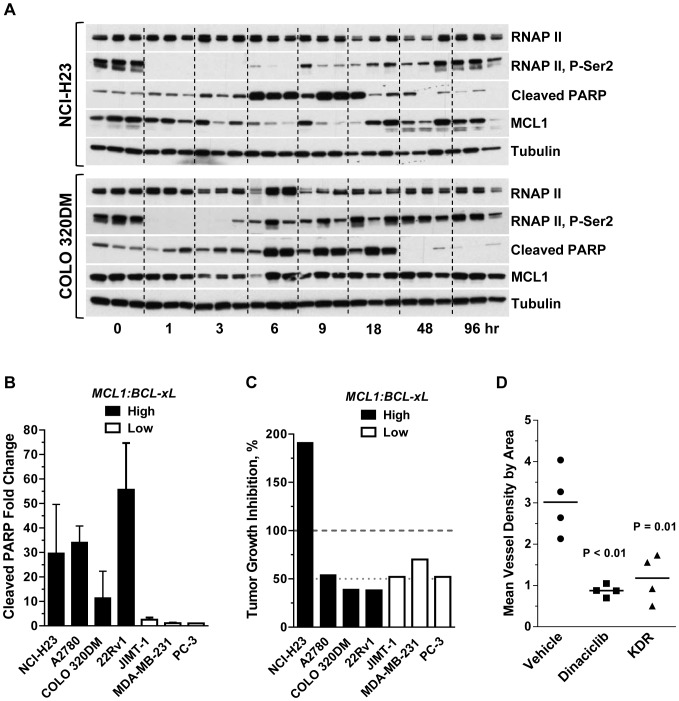
Dinaciclib exhibits apoptotic-induction, tumor efficacy and antiangiogenic activity in human tumor xenograft models.(A) Immunoblot analysis of lysates prepared from NCI-H23 and COLO 320DM xenograft tumors resected at 1, 3, 6, 9, 18, 48 and 96 hr after a single 40 mg/kg, i.p. dinaciclib injection. Time 0 is a 1 hr vehicle treatment. Represented are three tumors from three animals per time-point. α-tubulin is included as a loading control. Quantification of the cleaved-PARP fragment in these lysates is shown in supplemental Figure S4. (B) Quantification of cleaved-PARP fragment in lysates prepared from tumors resected 6 hr post-administration of vehicle or a single dose of dinaciclib at 40 mg/kg, i.p. Xenograft models designated as MCL11:BCL-xL high (filled bars) or low (open bars) mRNA ratio as defined in Figure S1 and Table S1. Fold change was determined from the mean of 3–5 dinaciclib-treated and 3–5 vehicle-treated tumors for each model. The mean and standard deviation are shown. (C) Efficacy of dinaciclib in 7 human xenograft models. Xenograft models designated as MCL11:BCL-xL high (filled bars) or low (open bars) mRNA ratio are indicated. Dinaciclib was given at 40 mg/kg, i.p., twice-weekly or 4qd. %TGI was measured at the end of the dosing period (n = 10 mice per group, except n = 8 mice in the JIMT-1 dinaciclib group). Tumor growth rates over the course of the study and endpoints are shown in Supplemental Figure S6. All dinaciclib-treated groups had mean tumor volumes that were significantly smaller than vehicle-treated groups at the end of study (p<0.05). (D) Antiangiogenic effect of dinaciclib relative to KDR inhibitor in A2780 xenograft tumors. Dinaciclib was given at 40 mg/kg, i.p., days 1, 4, 7 and KDR inhibitor was given at 10 mg/kg, po, days 1–7. Tumors were resected 2–4 hours after the last drug treatment. KDR-inhibitor compound B [19] was utilized as a positive control in these studies. Mean vessel density by area  =  % of endothelial cells divided by the total tissue area of interest [20].